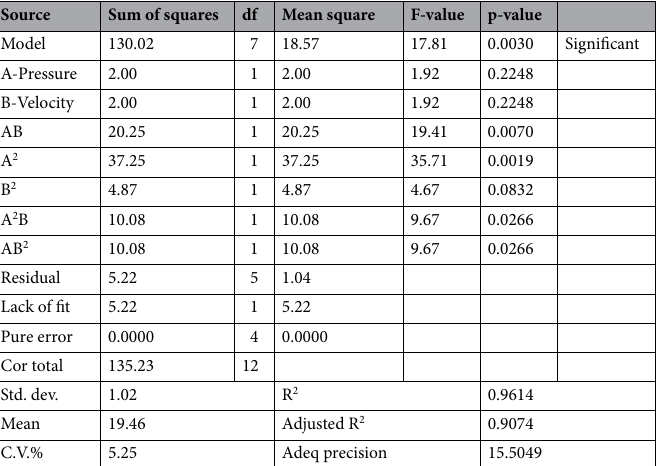
Table 16. ANOVA results for quadratic model (high peaks zone is response) of hot-rolled steel.